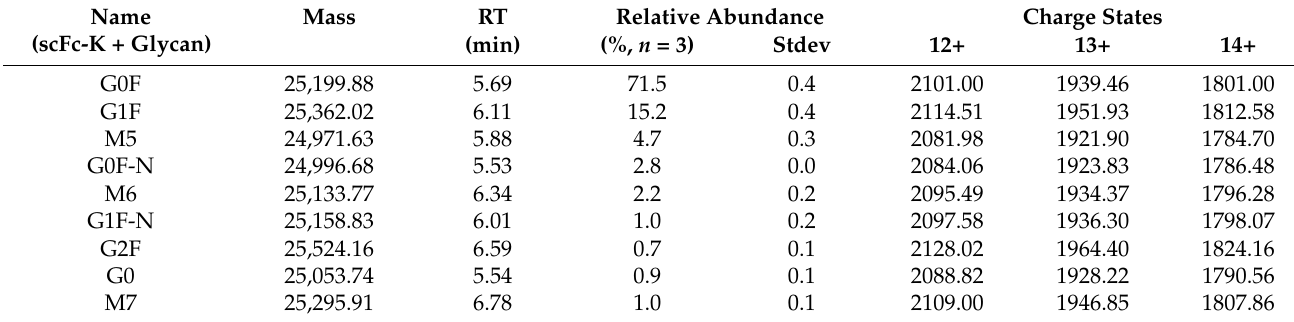
Table 2. Relative glycan quantification at the subunit level using the extracted ion chromatogram (XIC). Calculated masses and the corresponding charge states used for the XIC of each scFc + glycoform are displayed. Retention times and relative abundance levels (in %, with standard deviation) were determined based on the integrated XIC profiles ( n = 3). -K stands for C-terminal lysine